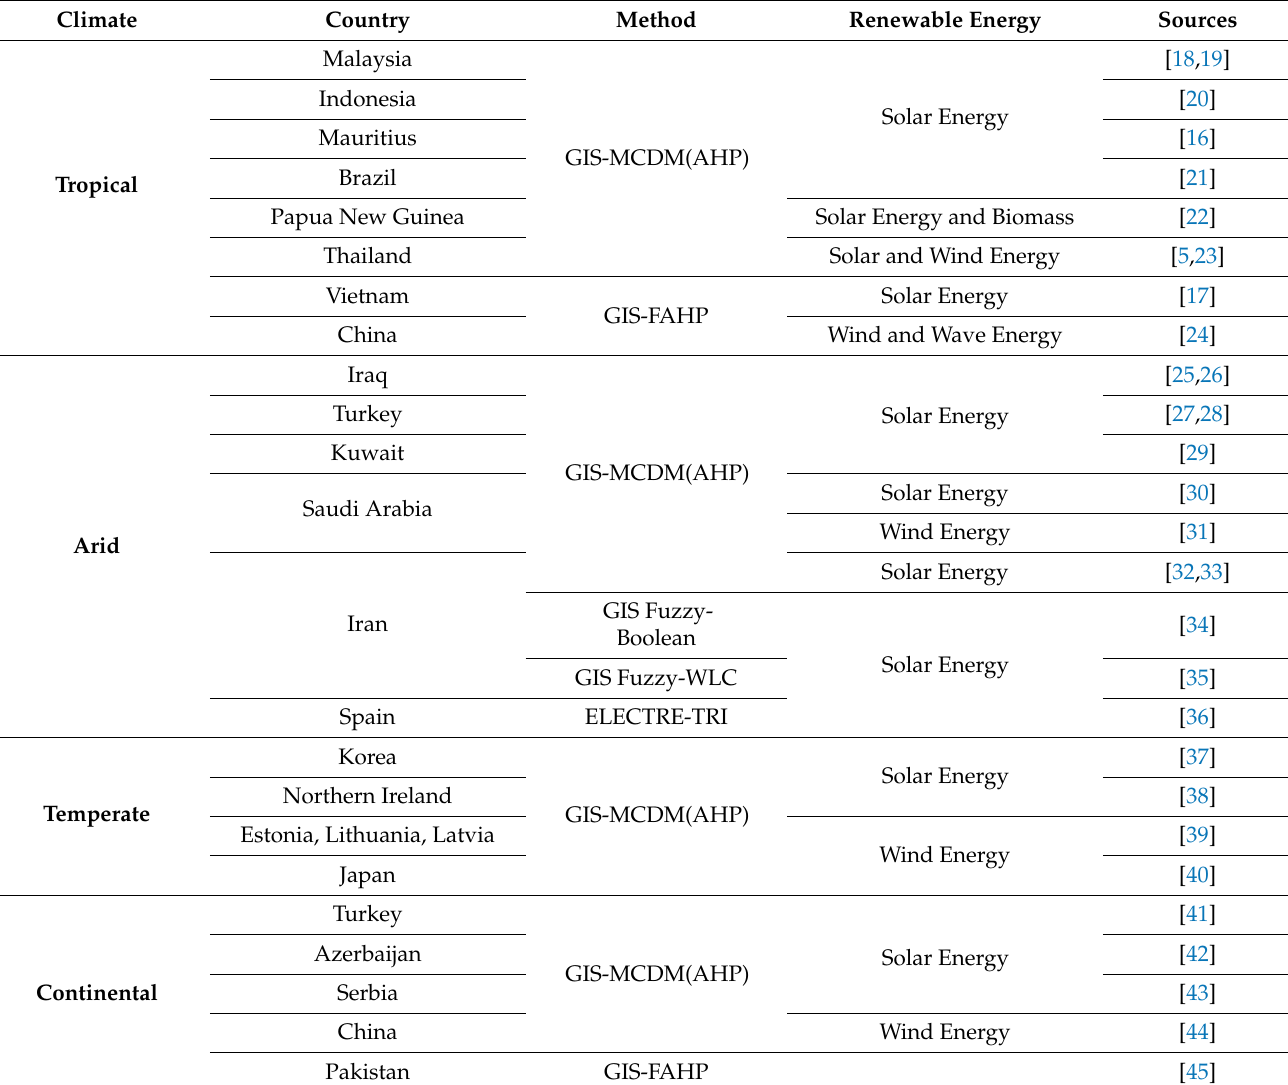
Table 1. Summary of the existing